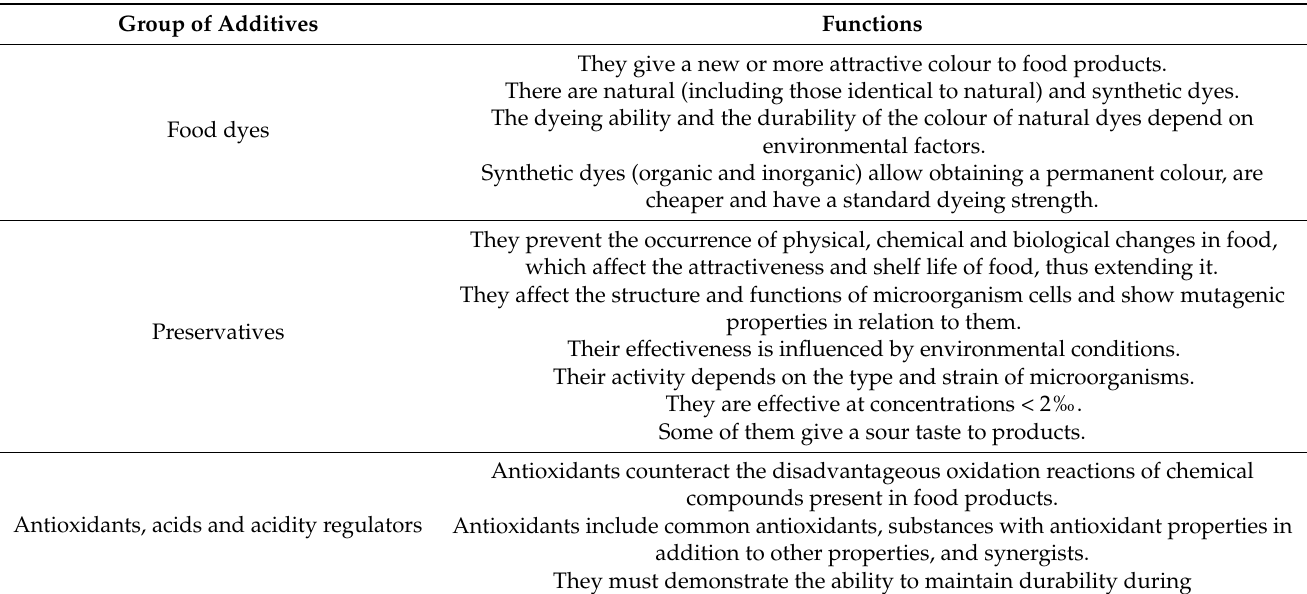
Table 2. Groups and technological functions of food additives. Own elaboration based on